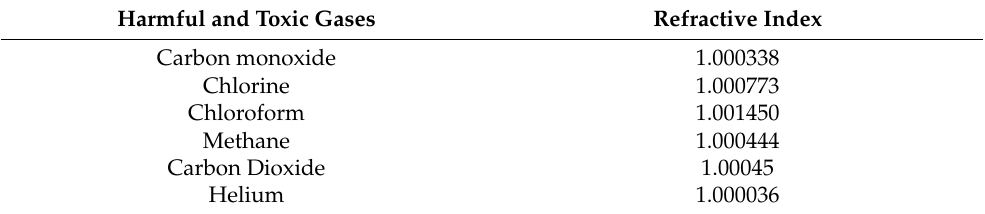
Table 1. Refractive Index of some harmful gases